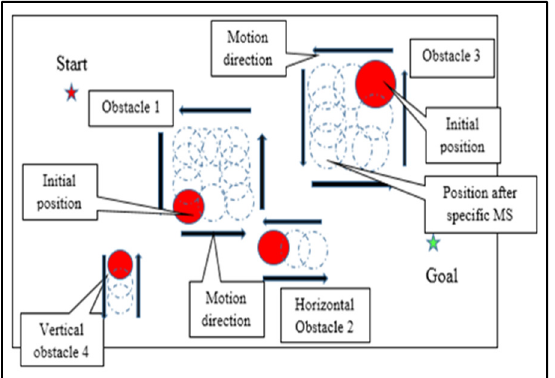
Fig. 4. The heuristic D* Via Point flowchart for known obstacle position dynamic environment.